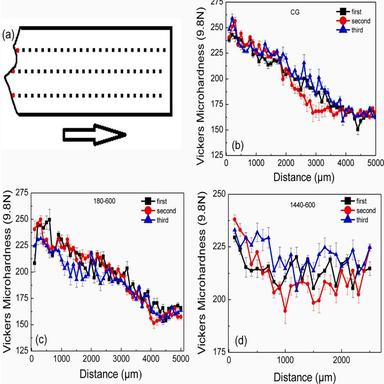
(a) Schematic of measuring Vickers microhardness from the fracture tip to the free end of impact samples and the dependence of Vickers microhardness on the distance from the fracture tip of (b) CG, (c) 180–600, and (d) 1440-600 samples.